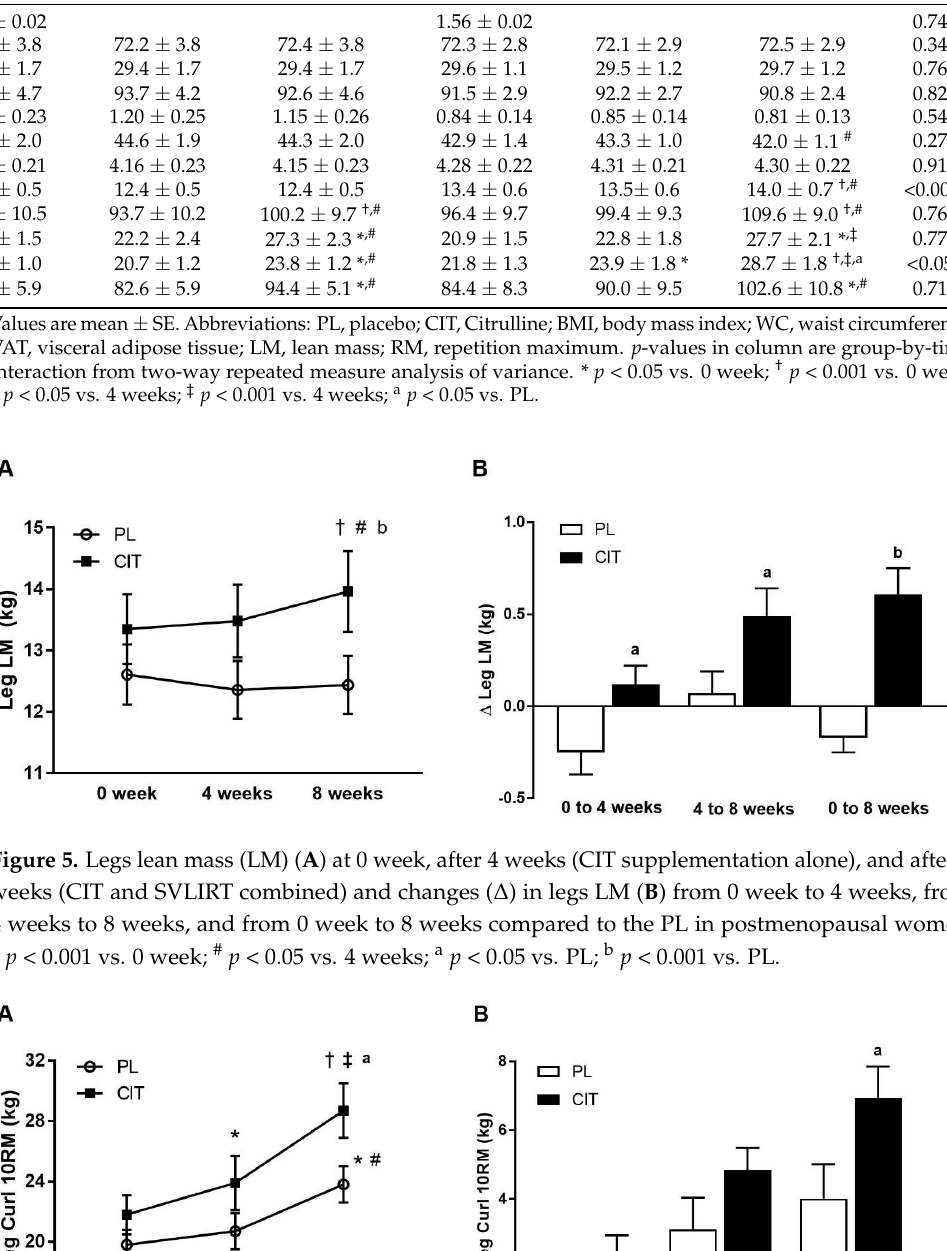
Table 3. Body composition and leg strength variables at 0 (baseline), 4, and 8 weeks of placebo and citrulline supplementation alone (0–4 weeks) and combined with resistance training (4–8 weeks).